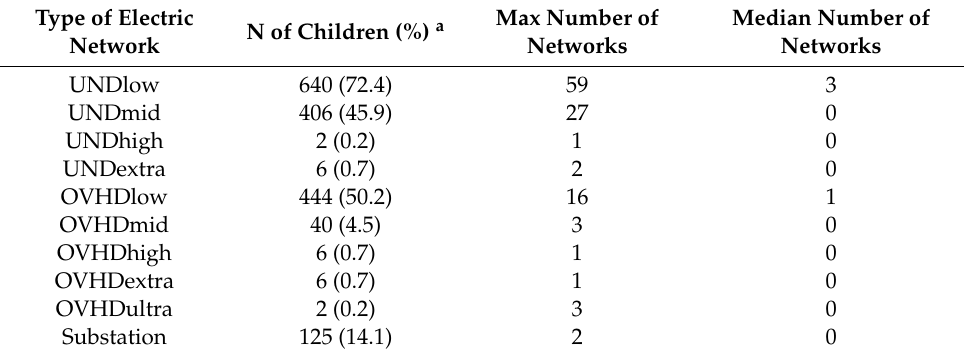
Table 1. Distribution of electric networks in the analyzed dataset. The table displays the number (and the percentage over the whole analyzed dataset of 884 children) of children that live close to each type of electric network and the maximum and median number of electric networks near the child home.